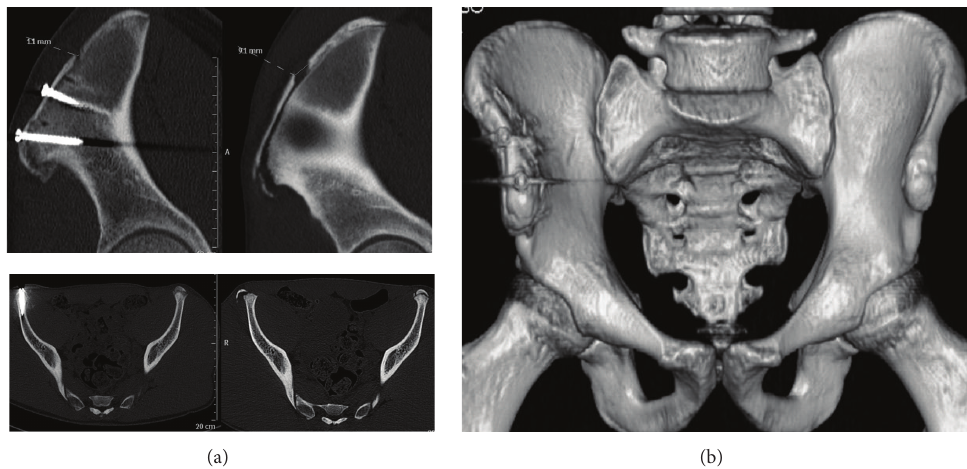
Figure 2: CT scan. (a) before (left) and after operation (right): reduction and internal fixation with two screws of the avulsion. (b) 3D CT scan. Good position of the fragment with two